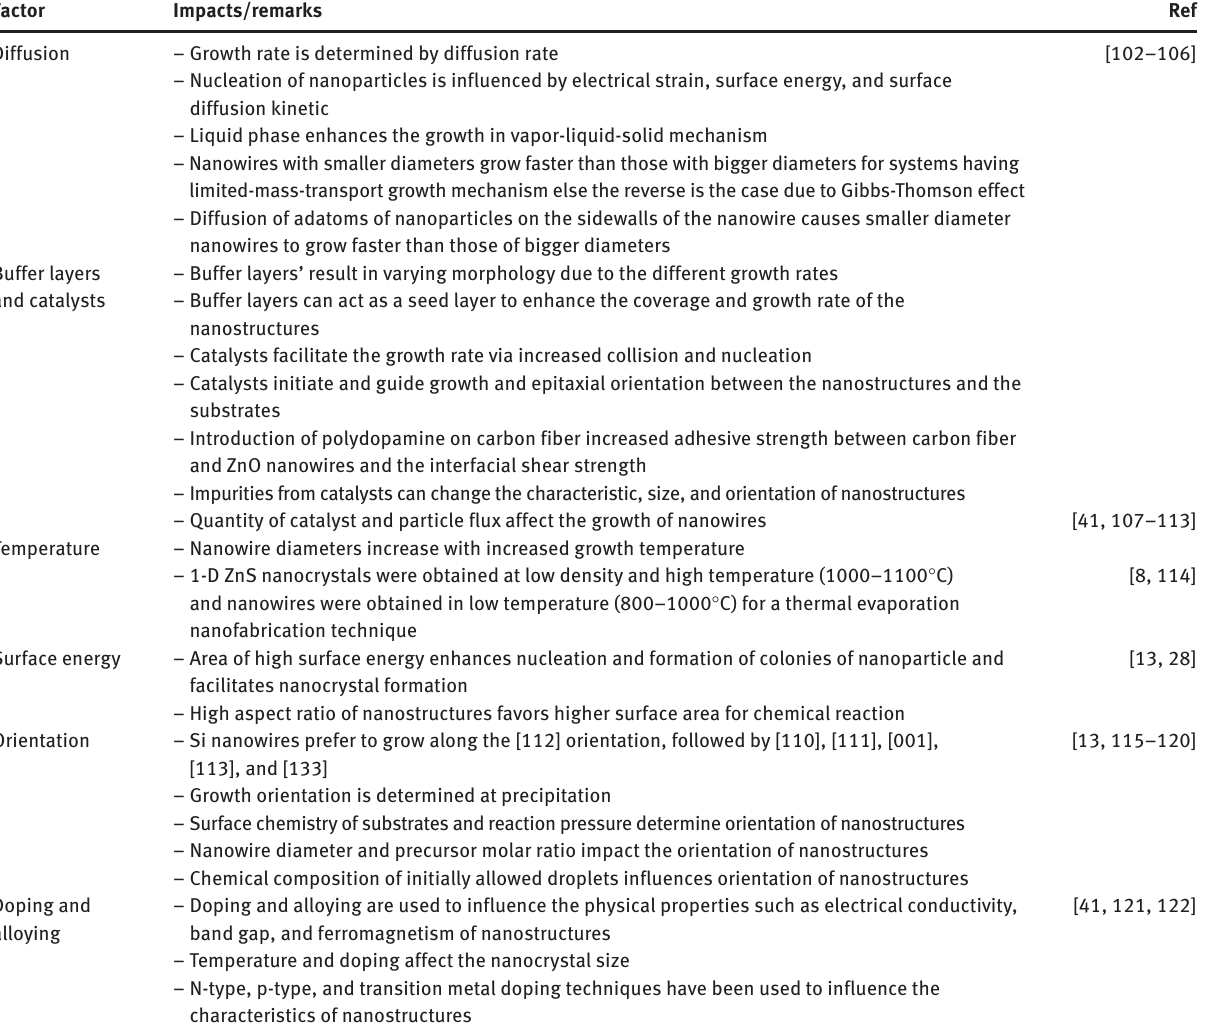
Table 2: Summary of some factors affecting the growth rate of